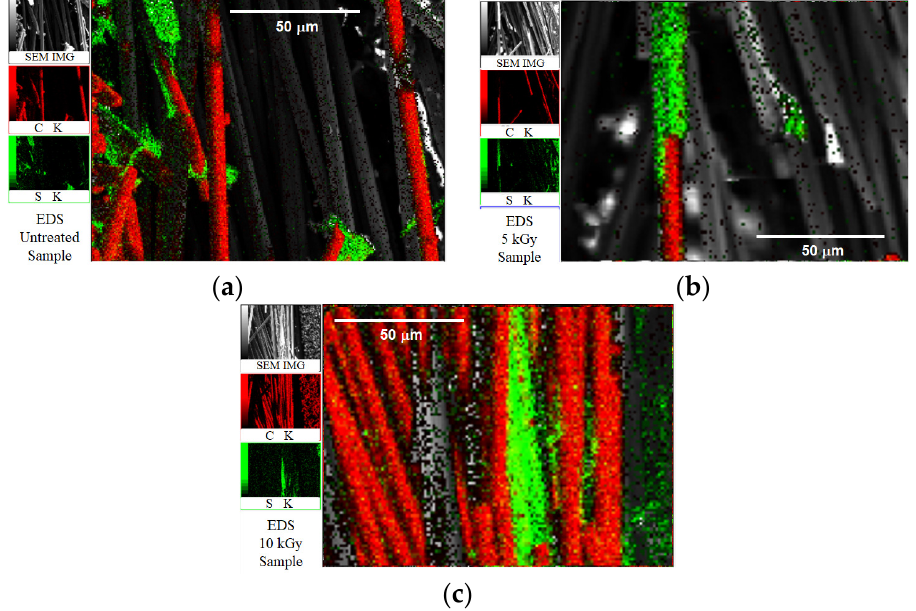
Figure 12. EDS mapping of fracture surfaces of untreated ( a ) 5 kGy ( b ) and 10 kGy ( c ) [PPS] 4 [CF] 3 samples, respectively.